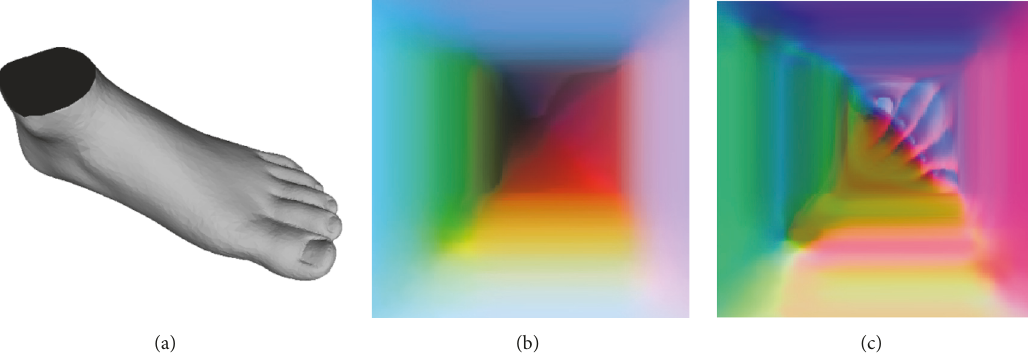
Figure 5: Geometry image (b) and normal-map image (c) for